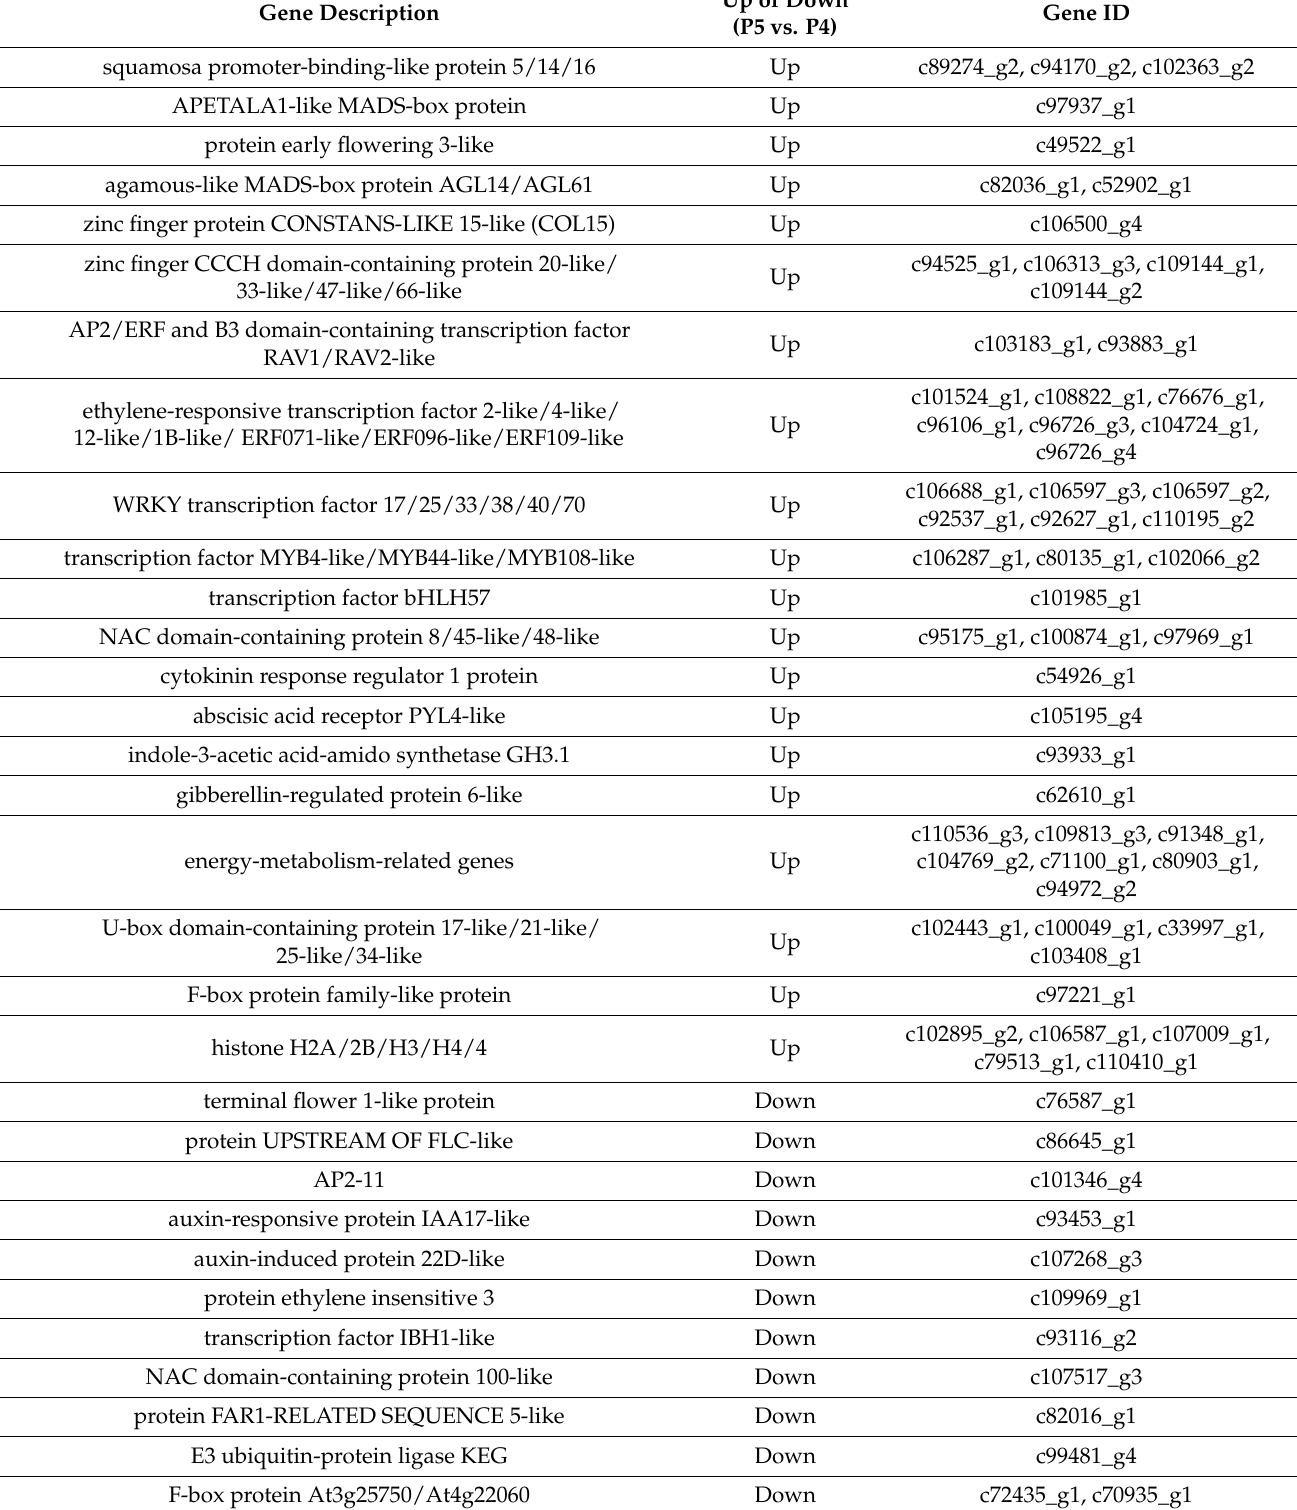
Table 3. Key up- and downregulated genes involved in flowering in Lycoris chinensis